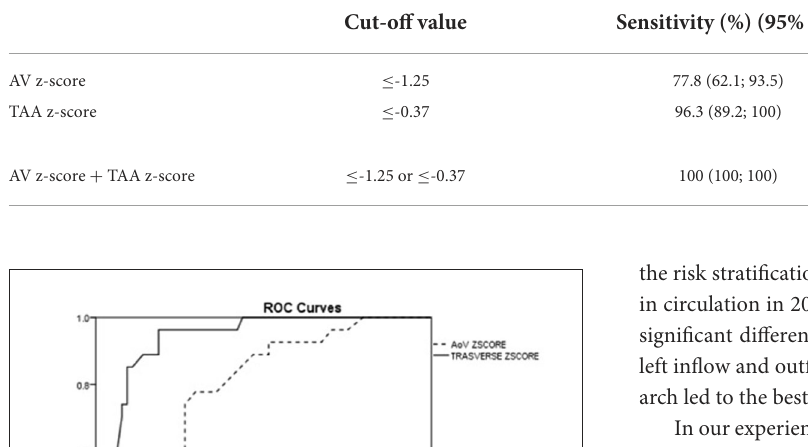
TABLE 4 Cutoff points, sensitivity, specificity, and 95% confidence interval (CI) for CoA.